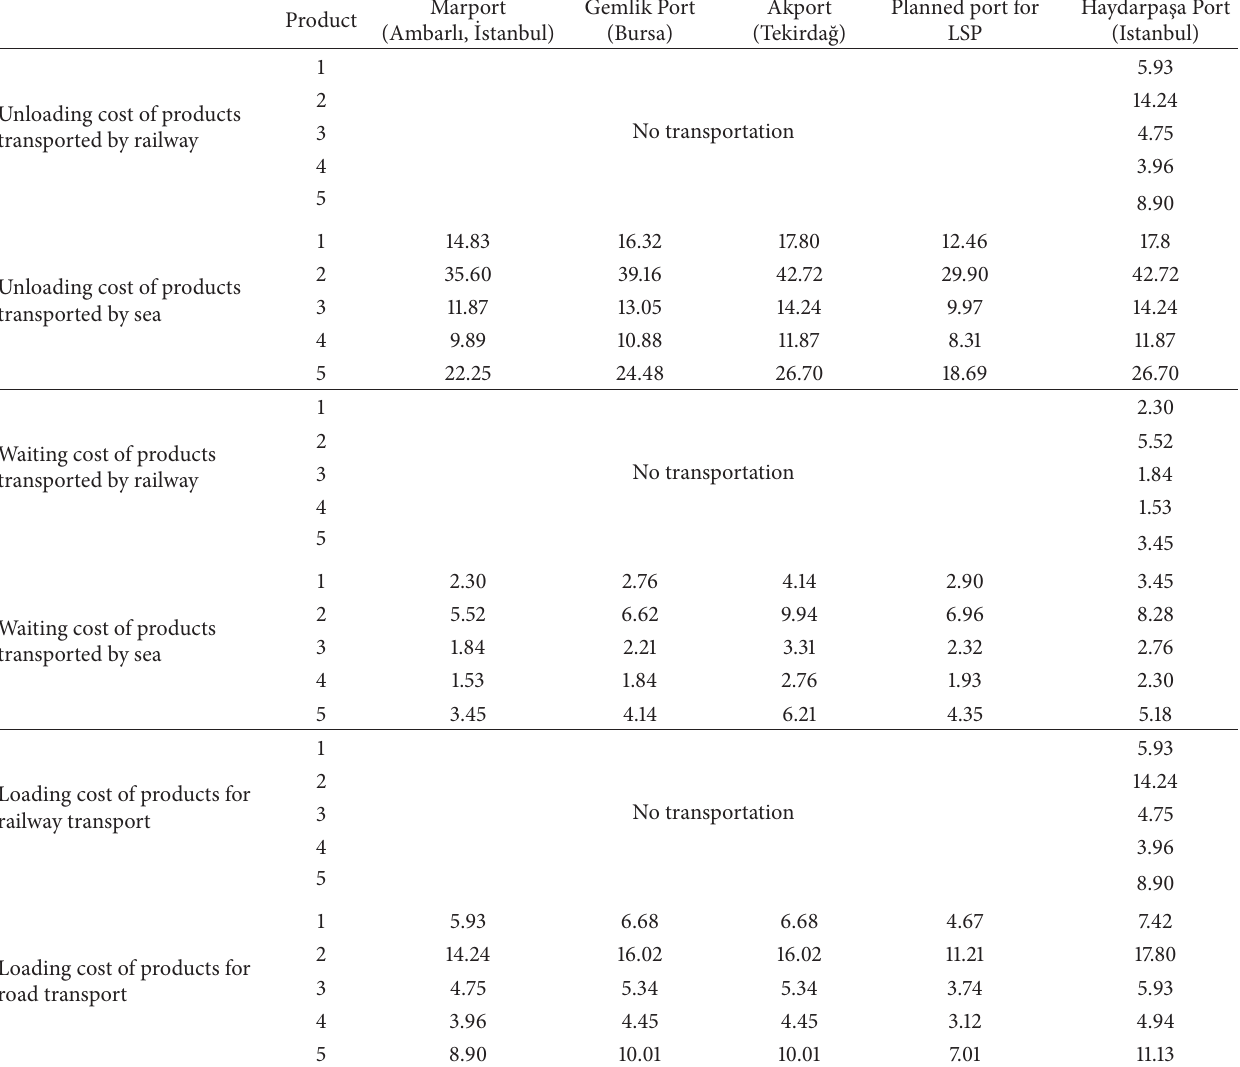
Table 12: Product based unloading, warehousing, and loading costs in the second transshipment terminals (TL/product).